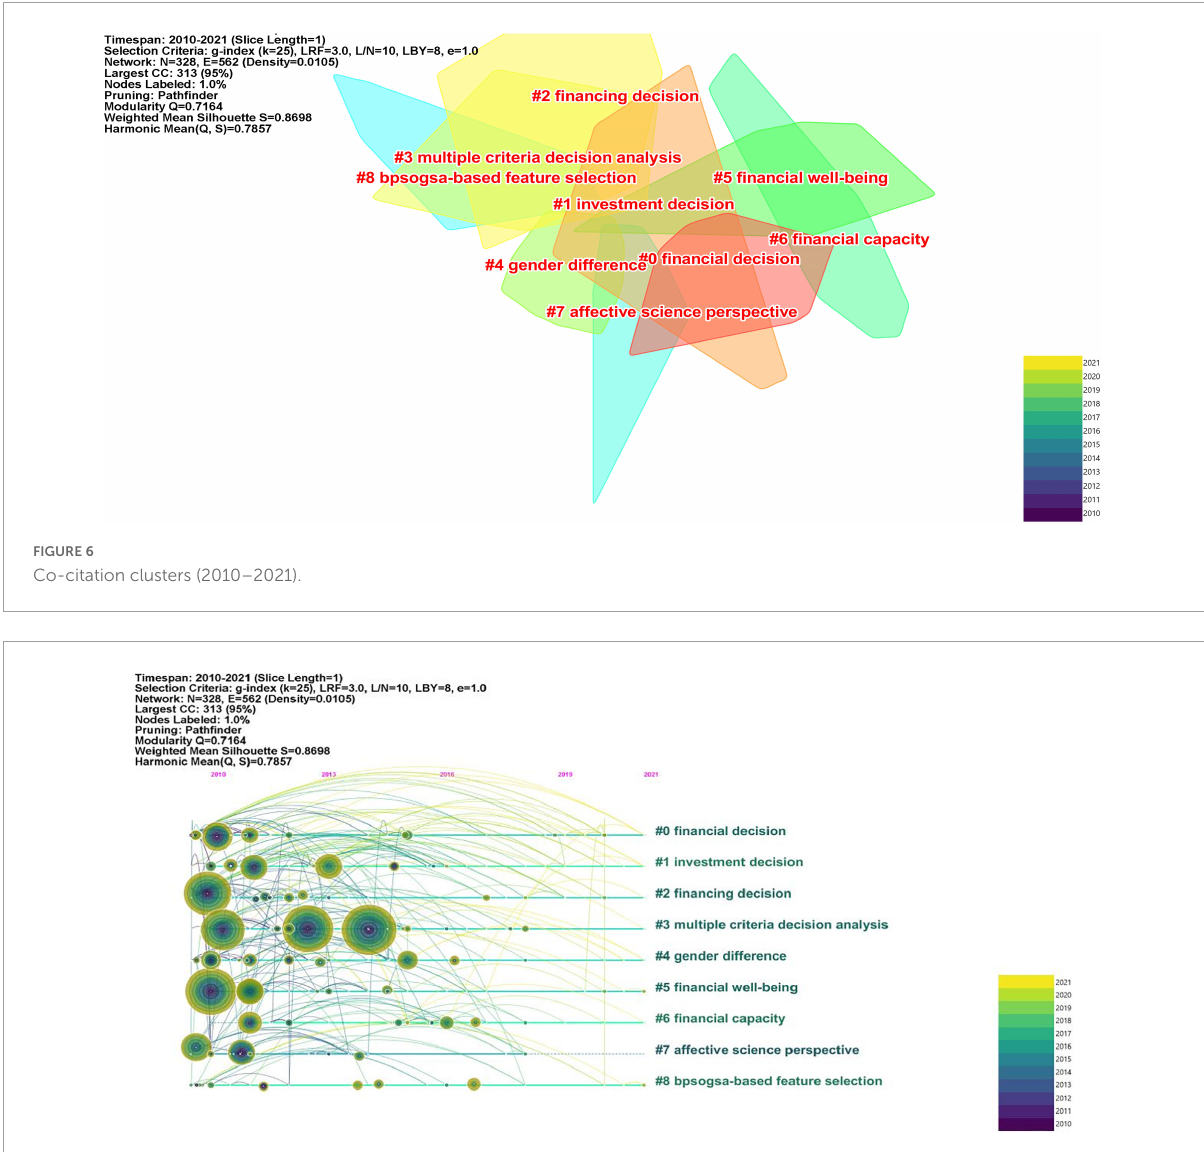
FIGURE7 Timeline view of the financial decision-making knowledge